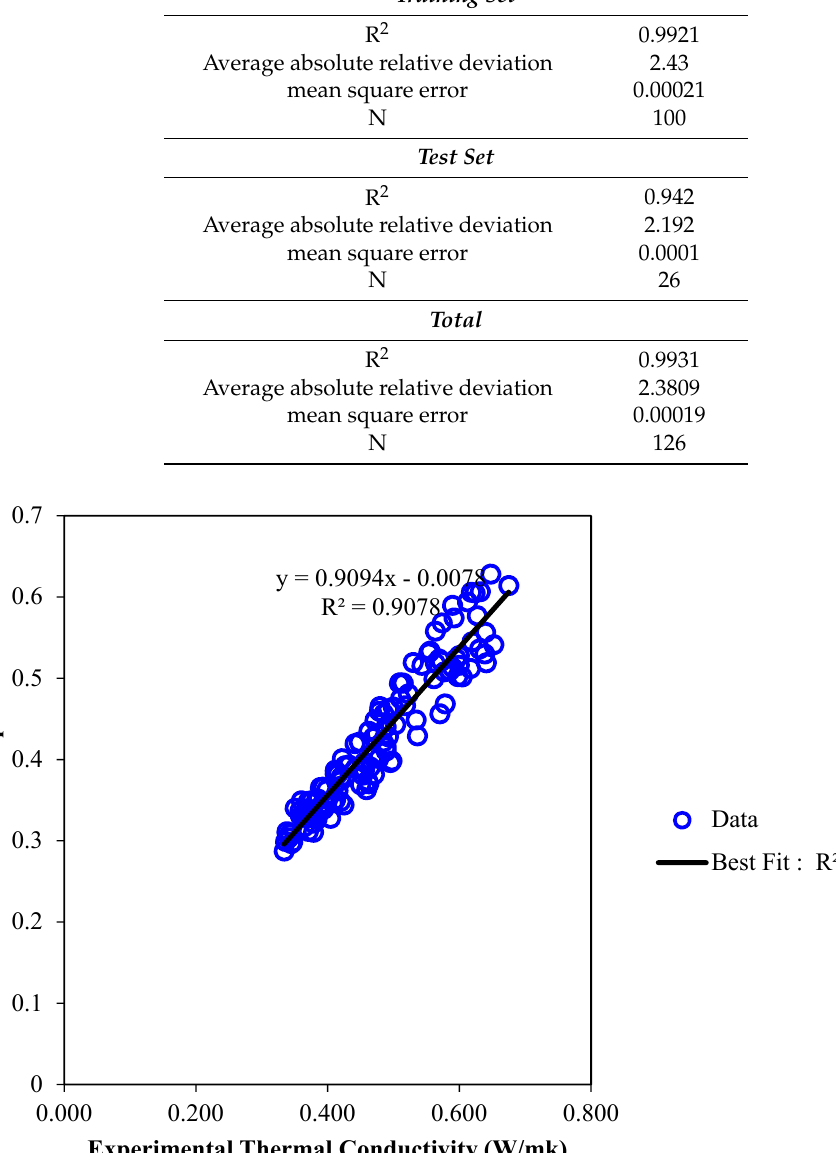
Figure 20. Regression plot of the proposed PSO-ANN model versus actual thermal conductivity of Fe 2 O 3 /ethylene glycol-water nanofluid.